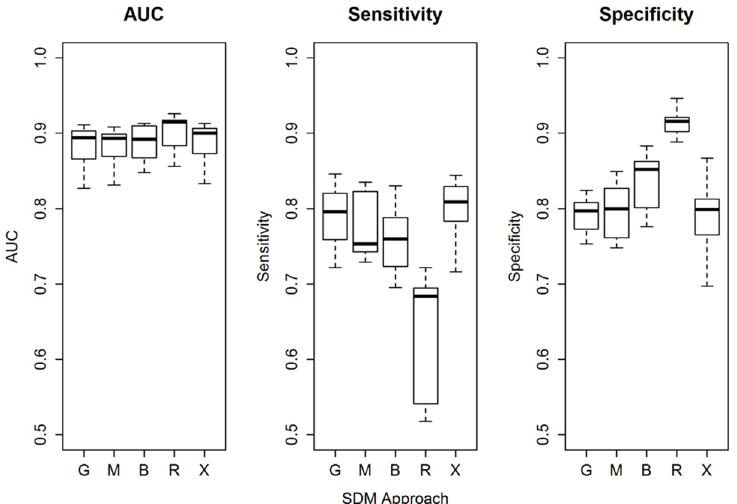
Fig 2. Boxplot comparing Area Under the Curve (AUC), sensitivity, and specificity statistics using test data and the cross-validation mean for each season and each of 5 forms using the final set of predictor variables in modeling patterns of season distribution of hoary bats ( Lasiurus cinereus ) in North America. G = Generalized Linear Models using logistic regression in a maximum likelihood framework; M = Multivariate Adaptive Regression Splines; B = Boosted Regression Trees; R = Random Forest; X = Maxent approach to maximum entropy modeling.